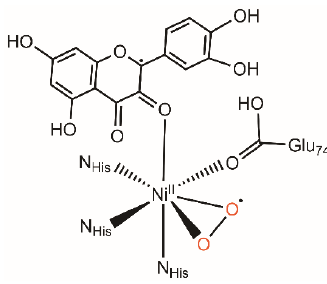
Figure 2. Representation of the active site features of cryotrapped Streptomyces sp. FLA in the presence of O 2 [50].